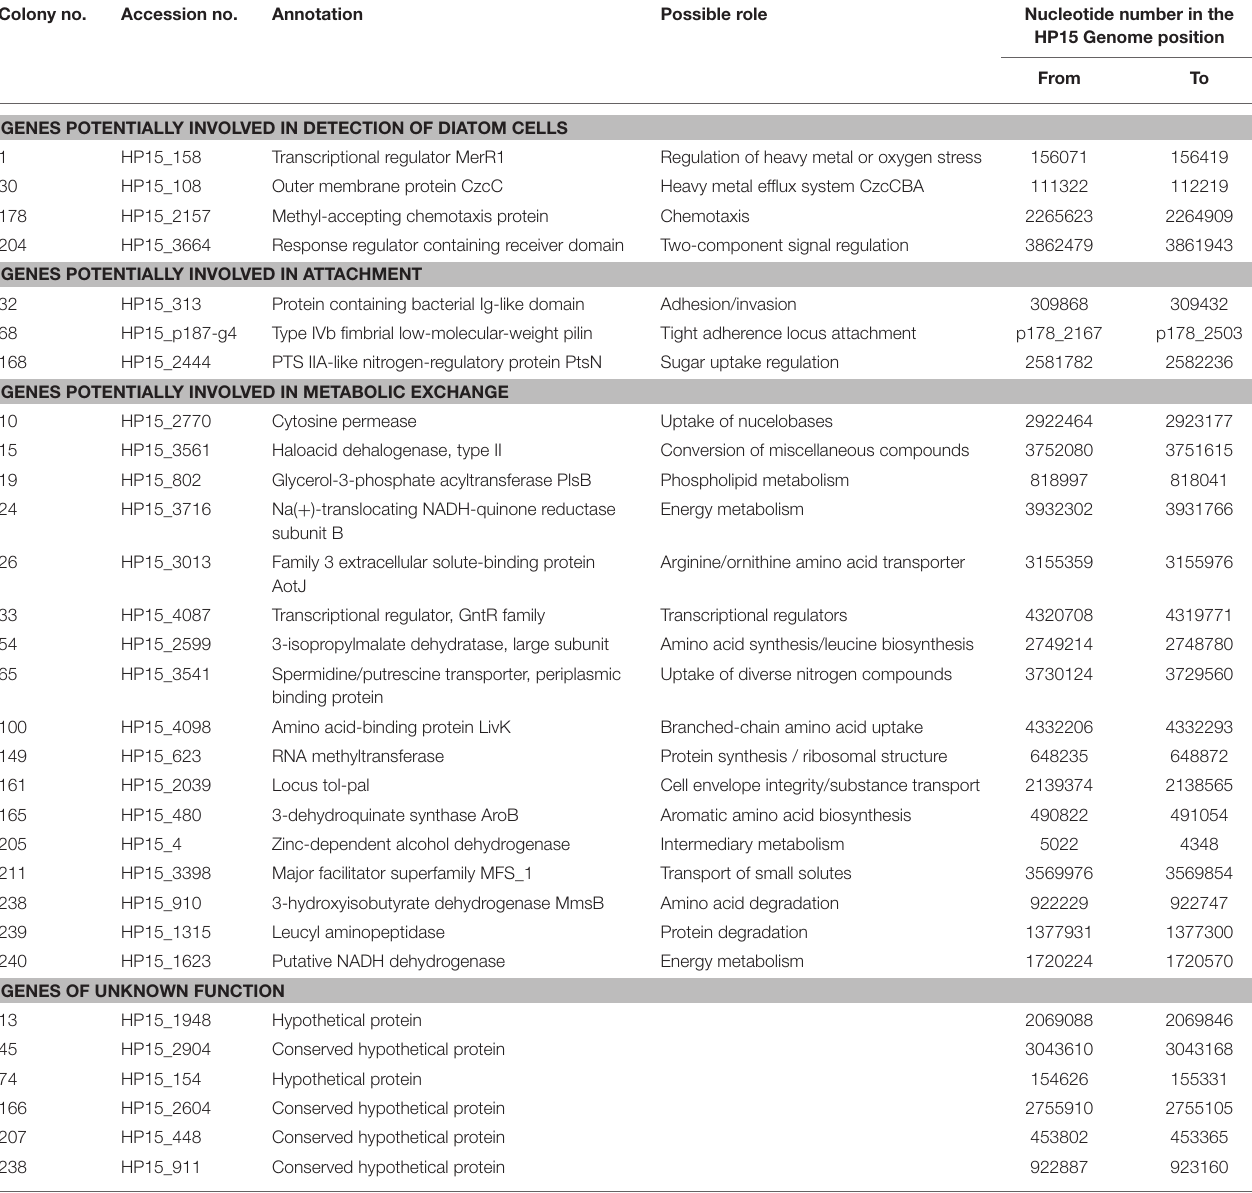
TABLE 3 | List of bacterial genes identified as being under control of the identified promoters during interaction with T. weissflogii . Colony no. Possible role Nucleotide number in the